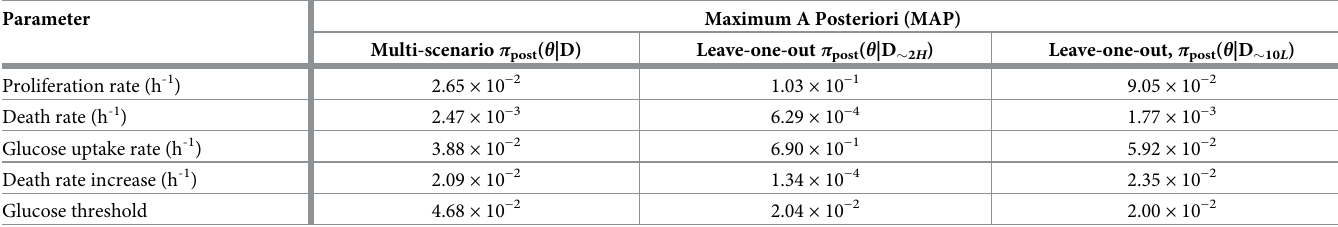
Table 3. Maximum A Posteriori (MAP)